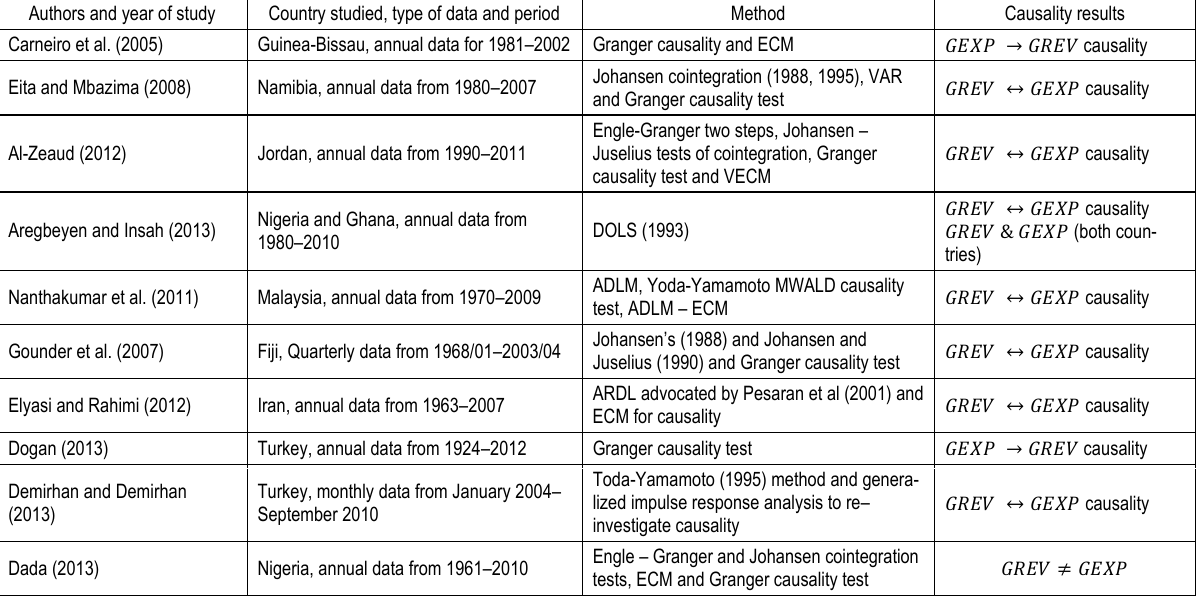
Table 2. Empirical studies that reviewed causality of government revenue –